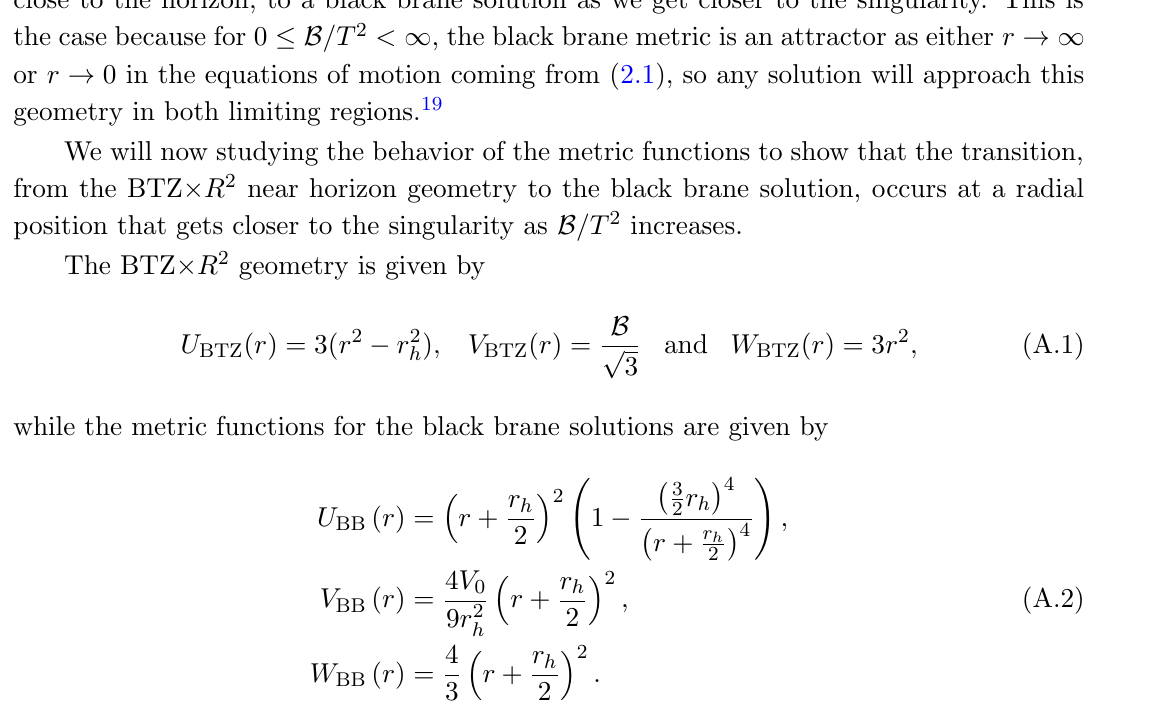
Figure 14 . (a) Metric functions U ( r ) (red) and V ( r ) = W ( r ) (blue) for functions U ( r ) (red), V ( r ) (blue) and W ( r ) (green) for vertical line corresponds to the